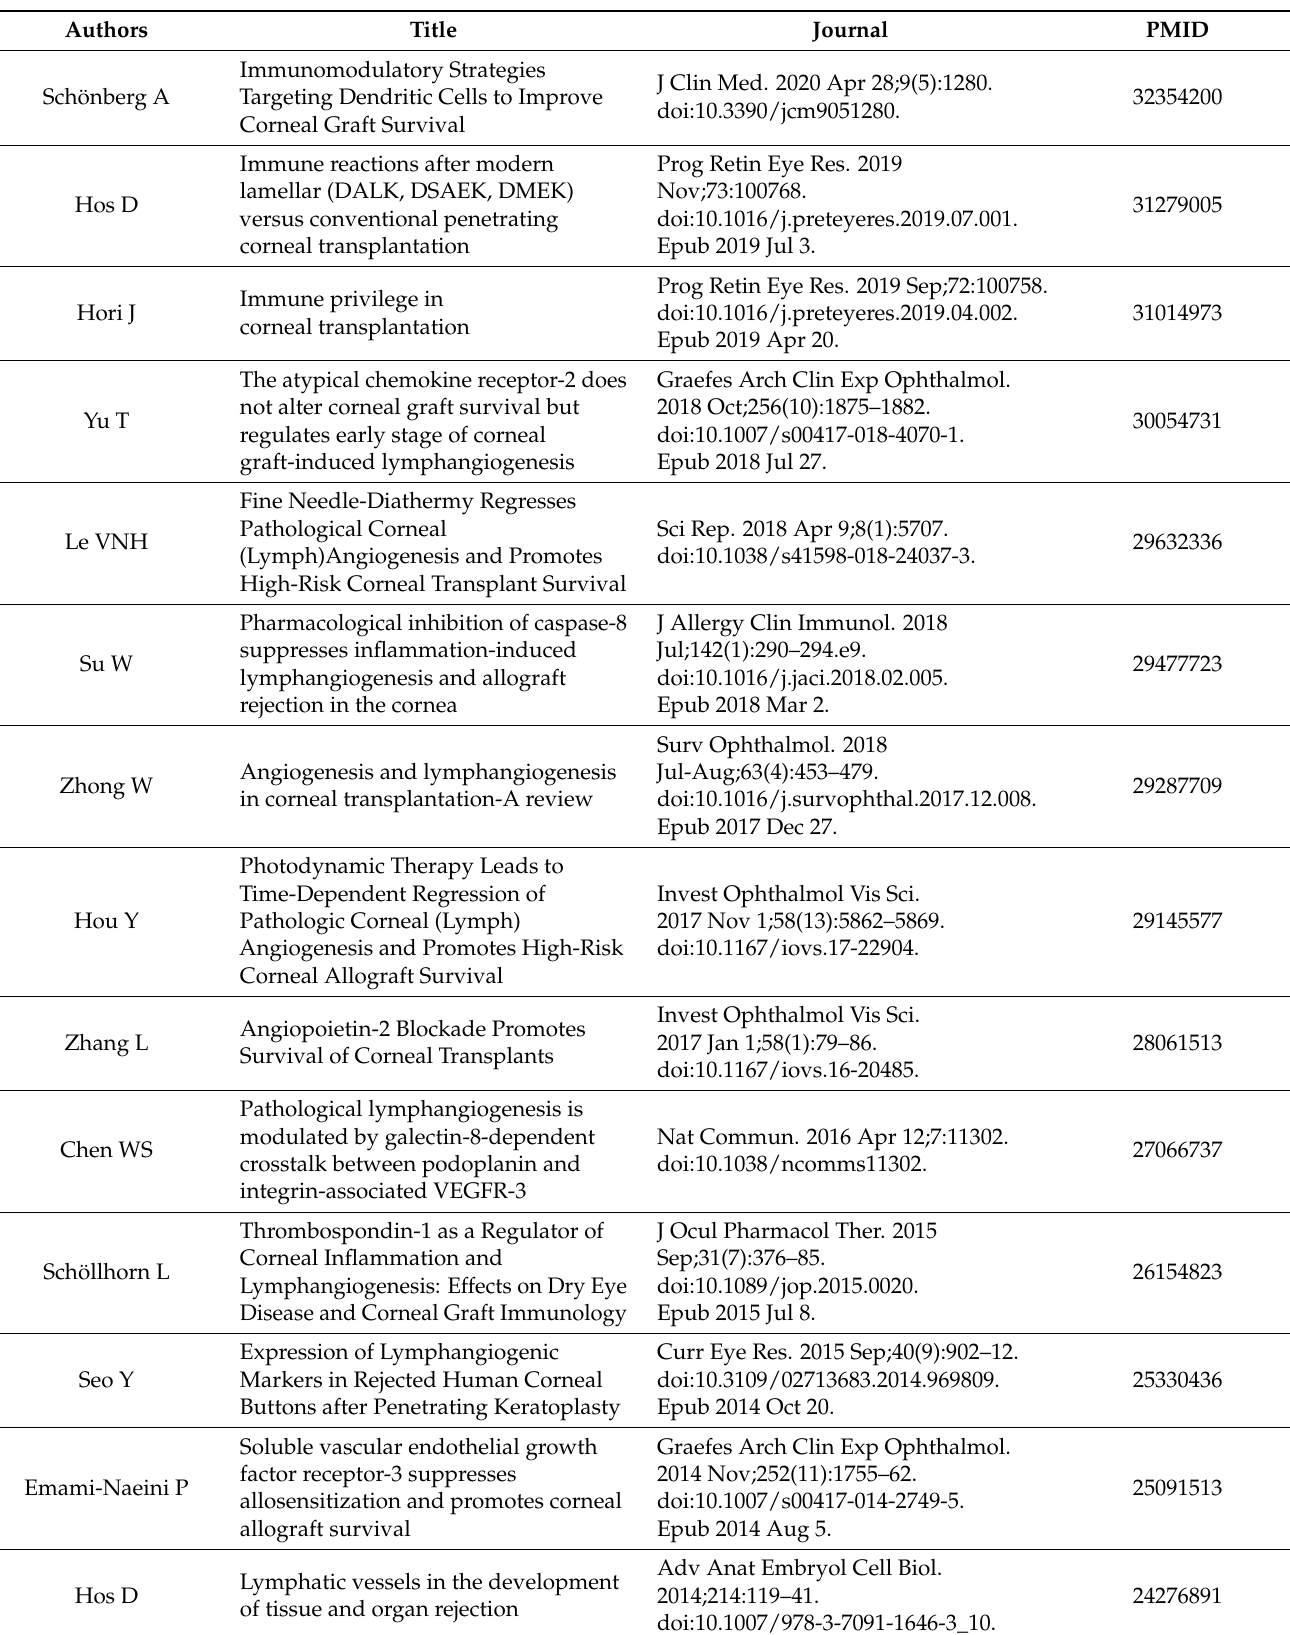
Table 1. Recent literature on corneal allograft rejection and